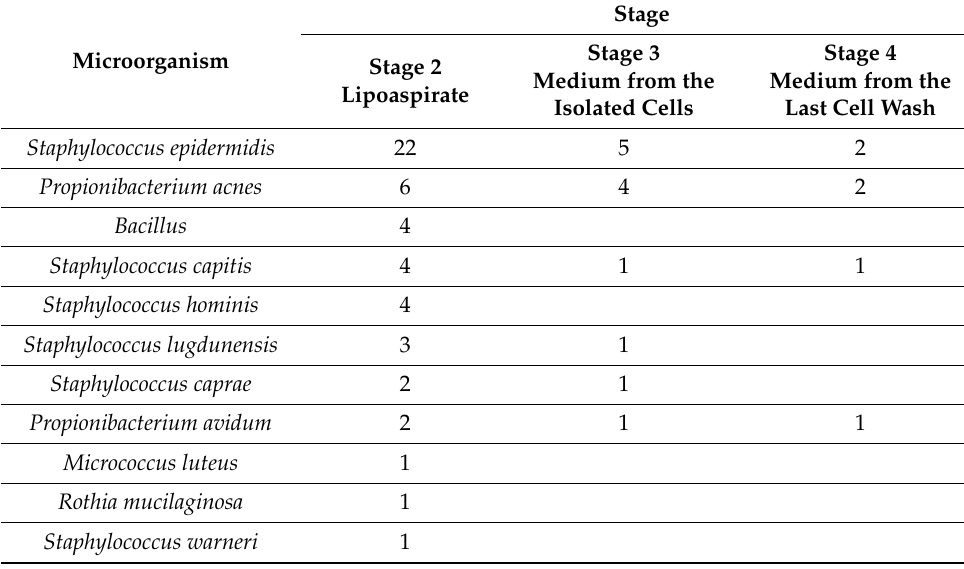
Table 2. The number of samples contaminated with specific microorganisms in the subsequent stages of the isolation process. The data include the results of all samples from stages 2 to 4 collected throughout the clinical trial. A single probe could be contaminated with more than one species. All isolated bacteria of the Bacillus genus are presented together. Empty fields listed in the table represent that no samples were contaminated with microorganisms for that particular stage of the isolation process. Stage Stage 4 Stage 3 Microorganism Stage 2 Medium from the Medium from the Lipoaspirate Last Cell Wash Isolated Cells Staphylococcus epidermidis 22 5 2 Propionibacterium acnes 6 4 2 4